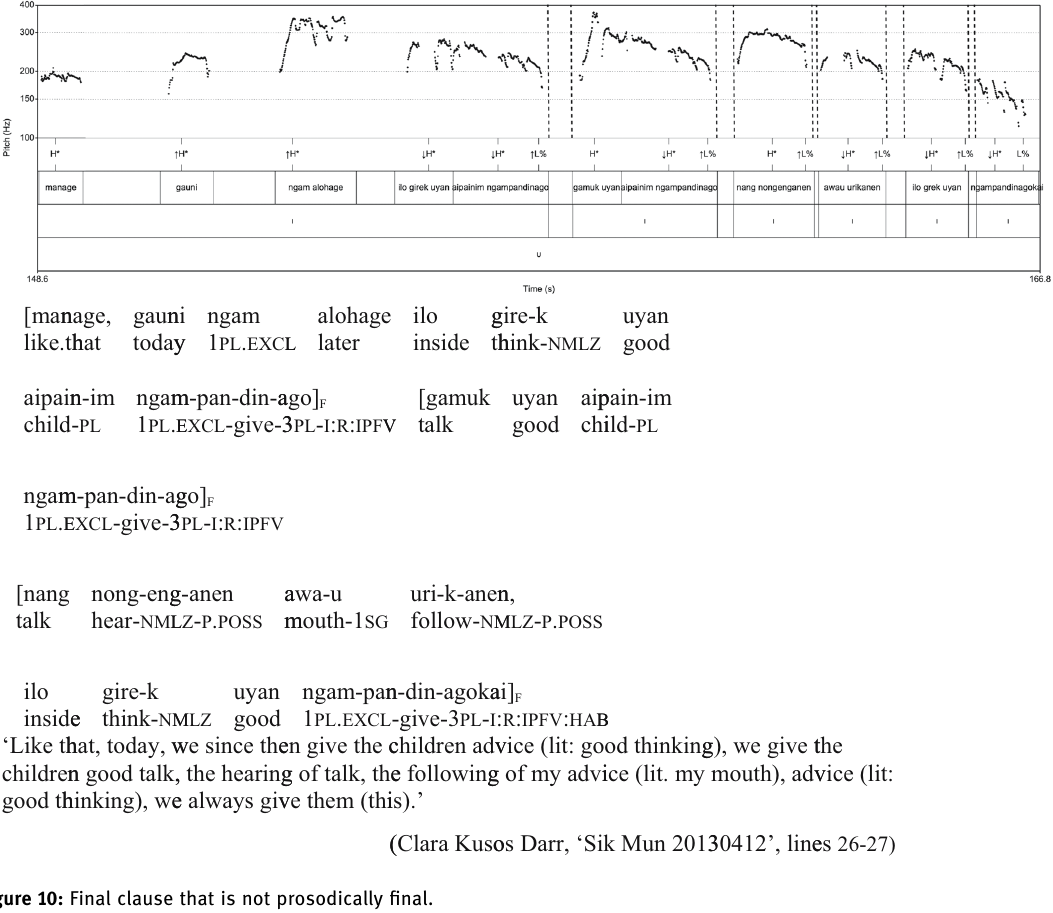
Figure 10: Final clause that is not prosodically fi nal.